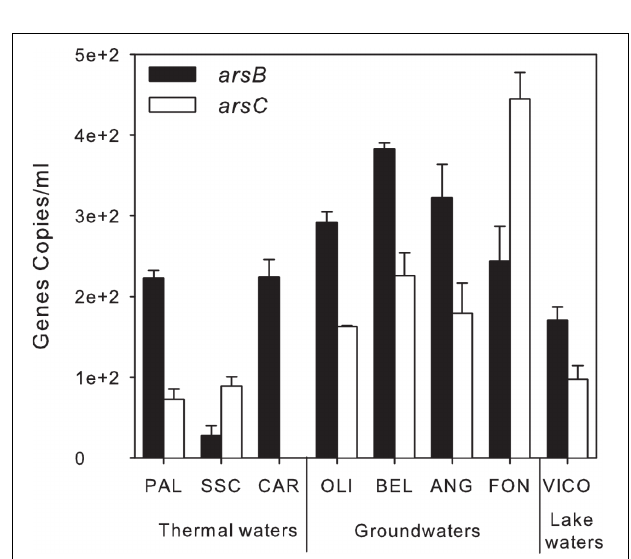
FIGURE 6 | Phylogenetic tree constructed with unassigned 16S rRNA gene sequences obtained from the thermal samples. Unassigned group 1 (76 sequences): PAL OTUs 3865/3142/1624/5721/7240; SSC OTU 5116. Unassigned group 2 (17 sequences): CAR OTUs 1743/886/2900. Unassigned group 3 (13 sequences): SSC OTUs 676/3207/8283/6610; Unassigned group 4 (6 sequences): PAL OTUs 5277/848; SSC OTUs 3302/1374/2608; CAR OTU 5062. Unassigned group 5 (58 sequences): SSC OTUs 1776/2215/8205/6801/8038/363/3362/4634/7530/3704/6025/535/4726/